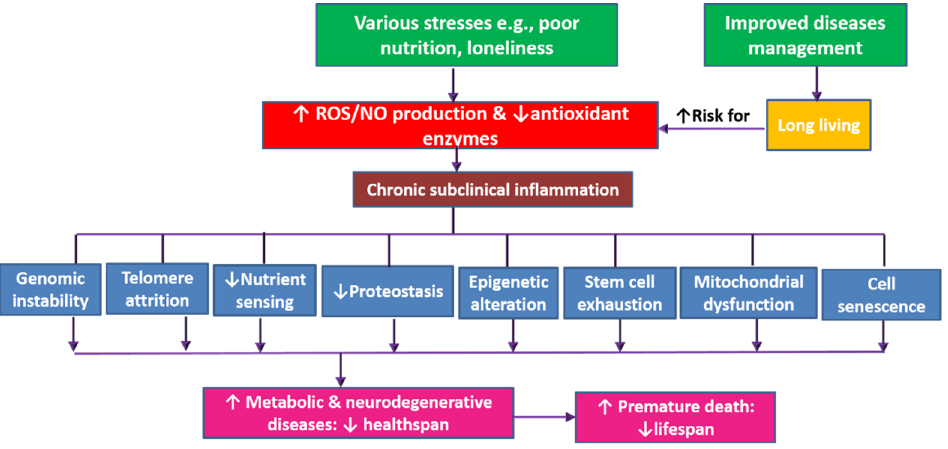
Figure 1. The dynamics of aging-related decrease of healthspan and lifespan. The production of free radicals increases with aging (which is on the rise out of improved disease management) and also with exposure to various stresses (e.g., pollution, poor nutrition, and psychological stress) leading to oxidative stress. This is associated with reduced production of antioxidant enzymes and activation of inflammatory pathways. Both oxidative stress and chronic inflammation lead to a trail of cellular and molecular alterations: telomere attrition, epigenetic alterations, genome instability, reduced proteostasis, disturbed nutrient sensing, mitochondrial dysfunction, cellular senescence, stem cell exhaustion, and altered intercellular communication. Such age-related physiological alterations result in poor health and loss of function out of increased occurrence of various metabolic and neurodegenerative disorders. Age-related disorders are associated with increased mortality and premature death i.e., decreased lifespan.